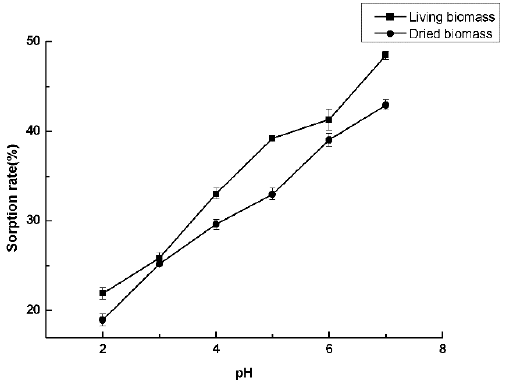
Figure 9. pH effect of both biomass sorption patterns. ( p = 0.009).